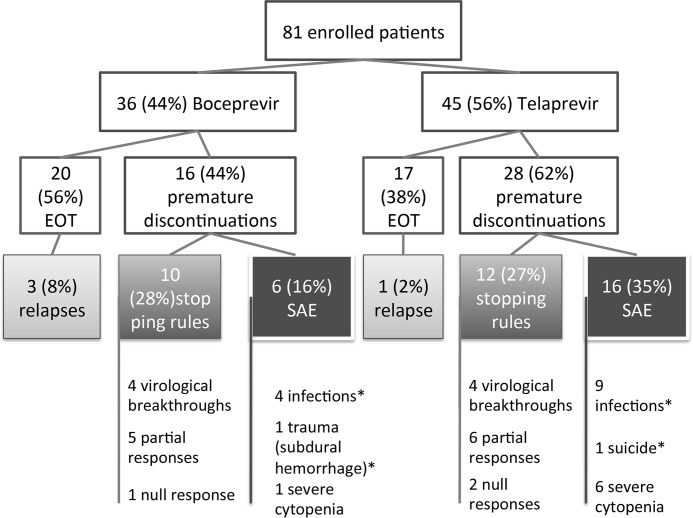
Flowchart describing premature discontinuations and treatment failures.Among the patients who discontinued treatment because of adverse events, five nevertheless achieved an SVR24 (two in the BOC group and three in the TVR group).* indicates the causes of death in this cohort: four deaths from infection (two in each group) and two other causes as shown here.